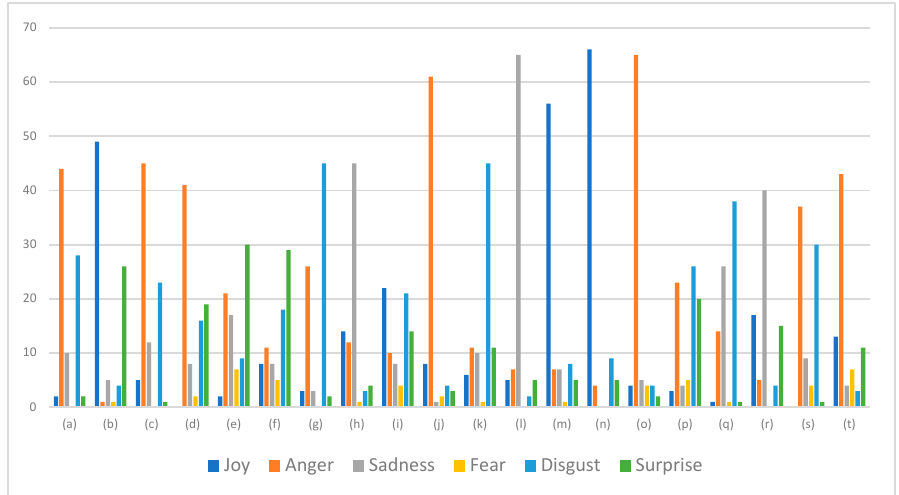
Figure 6. Label count for each gesture category.